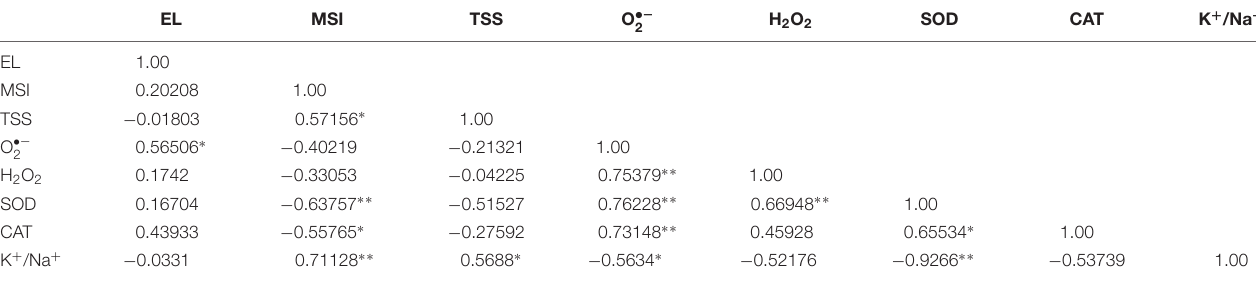
TABLE 4 | Correlation coefficient(r) between biochemical parameters of transgenic and WT plants exposed to 150 µ M SA stress.